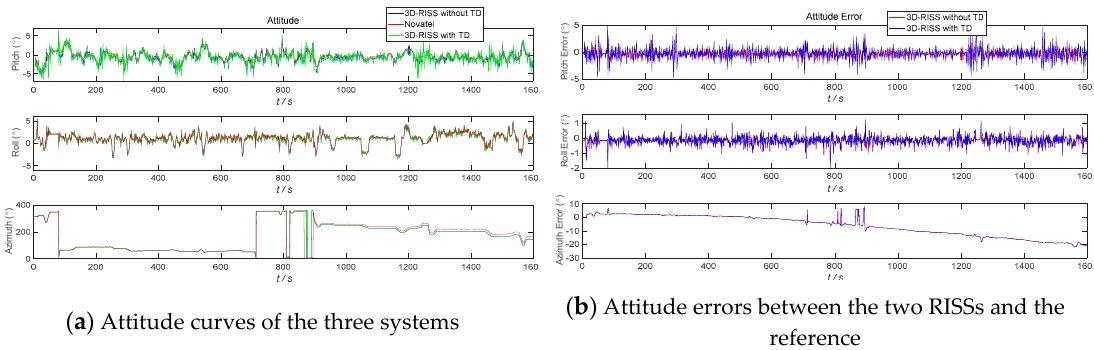
Figure 5. RISS attitude and attitude errors with the original odometer velocity filtered by TD.